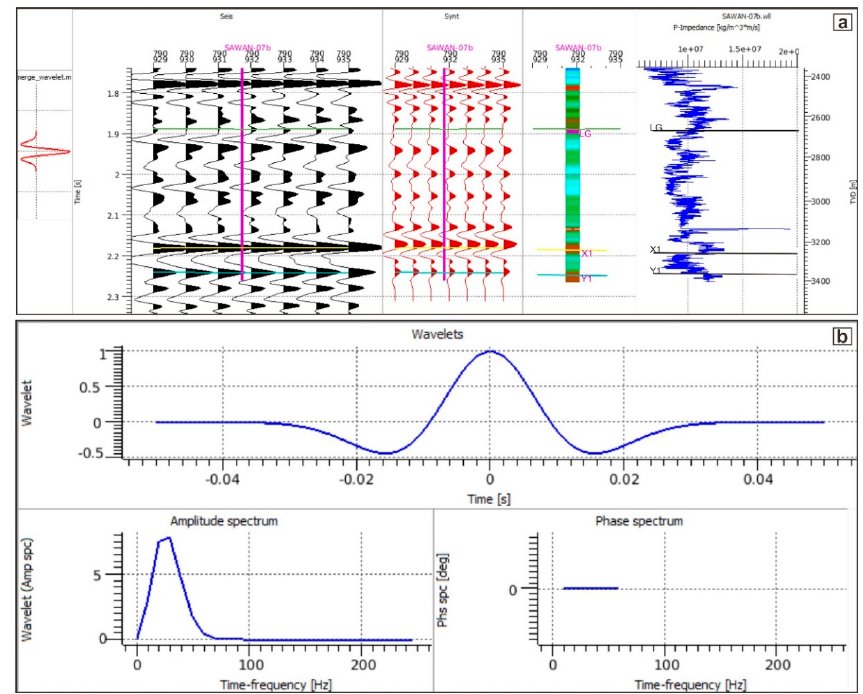
Figure 7. ( a ) Seismic-to-well tie among synthetic and seismic traces of S-07. X1 and Y1 horizons show the ZOI. ( b ) Average wavelet extracted along with amplitude and phase spectrum for study wells. The amplitude spectrum was calculated via auto-correlation, and the phase of the seismic data was removed through auto-correlation. The spectrum was smoothed using a time-taper to the auto- correlation function. The parameters set for estimating the wavelet are shown in Table 1. Table 1. Selected parameters for optimum wavelet estimation.